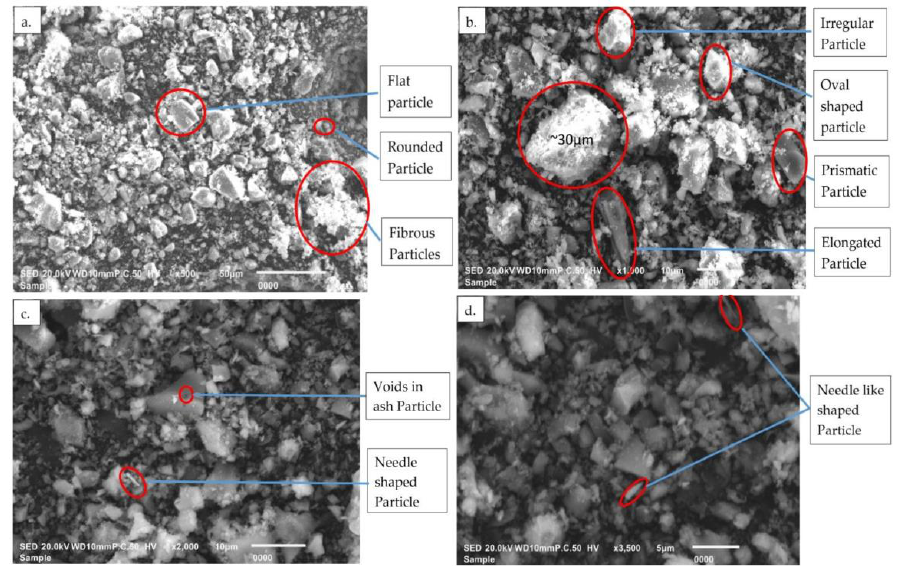
Figure 2. SEM image of ground SCBA ( a ) at 500 magnification, ( b ) at 1000 magnification, ( c ) at 2000 magnification, and ( d ) at 3500 magnification.